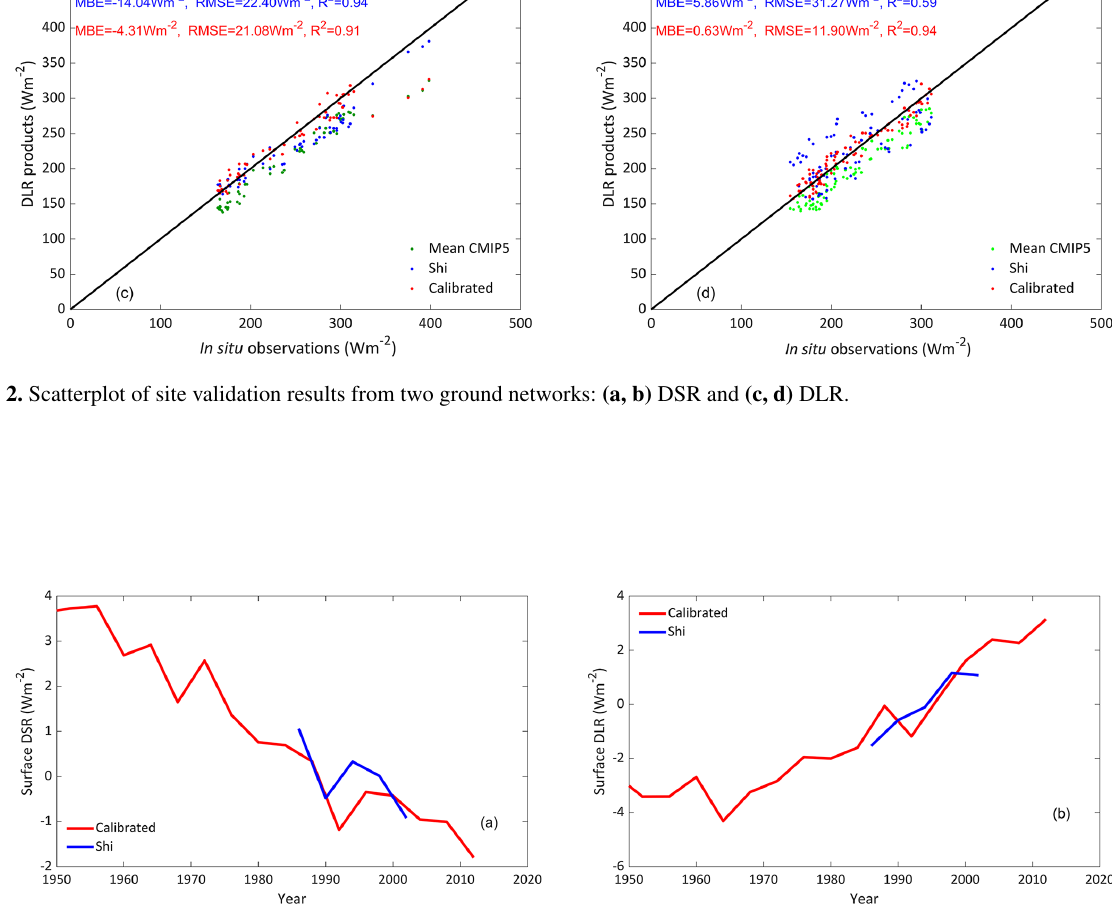
Figure 3. Trend comparison between calibrated downward radiation datasets and Shi and Liang (2013). Temporal variations over the TP in panels (a) and (b) were averaged by the 5-year moving window in order to remove the impact of annual